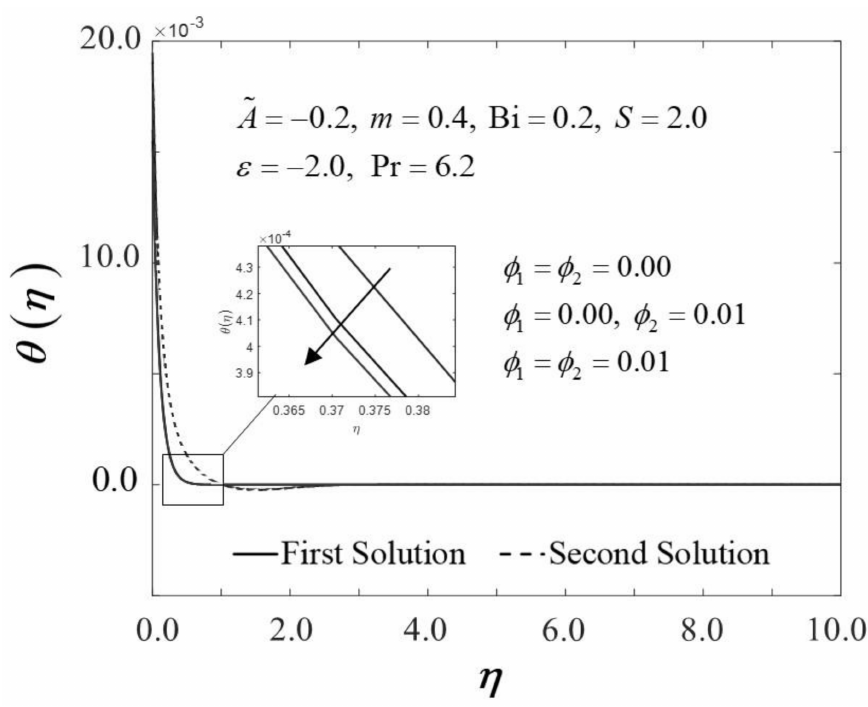
Figure 5. Trend of θ ( η ) with η and assorted φ